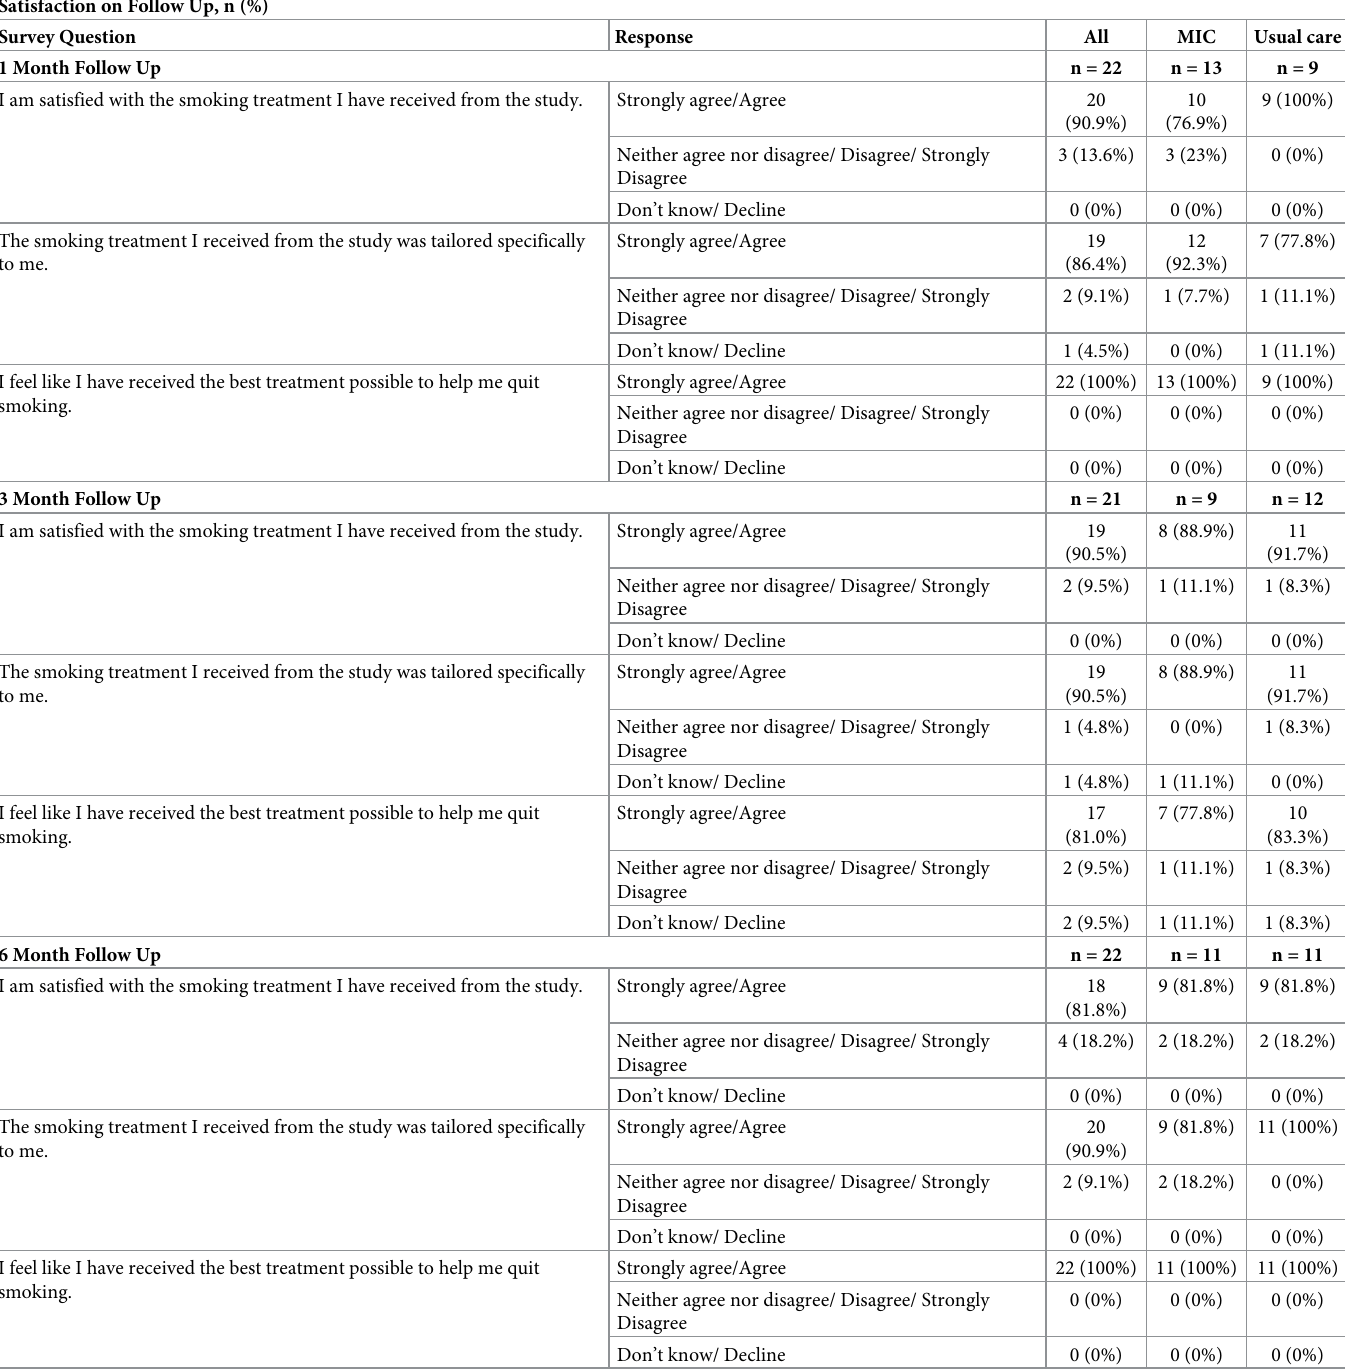
Table 5. Participant reported satisfaction with intervention at 1-, 3-, and 3-month follow ups. Satisfaction on Follow Up, n